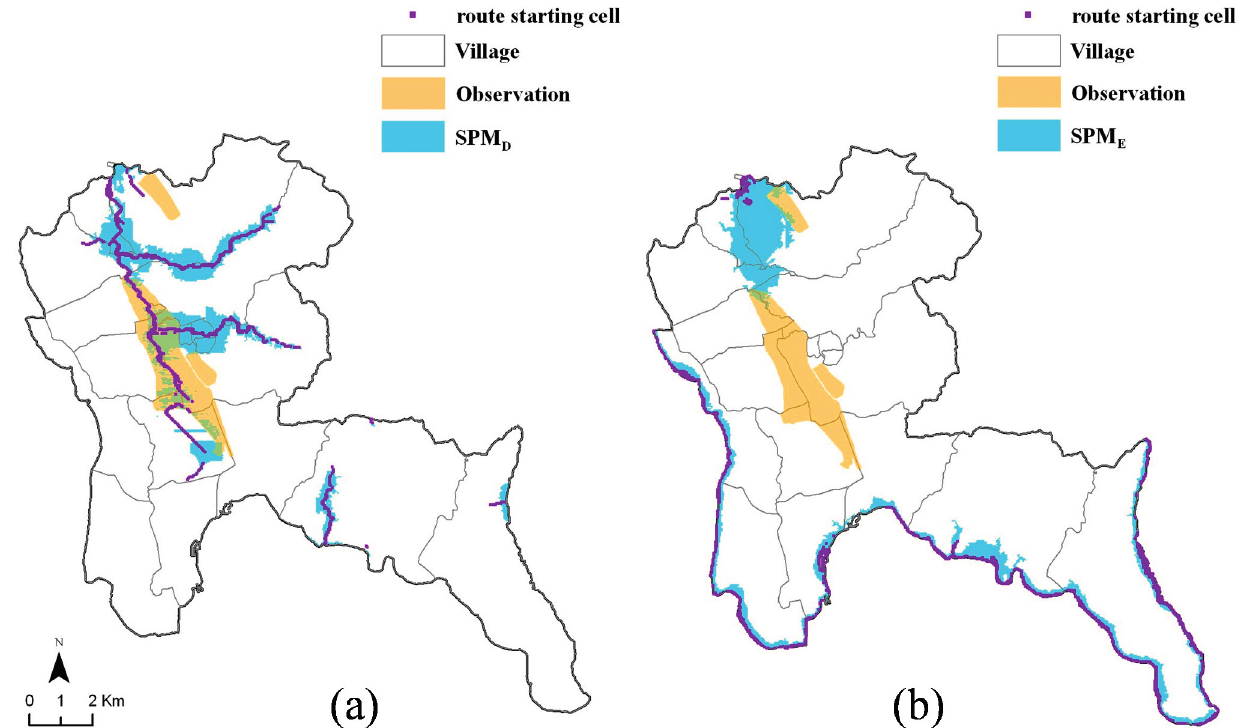
Figure 9. Overlapping flood areas at the grid level between the observed floods and SPM D ( a ) and SPM E ( b ) in